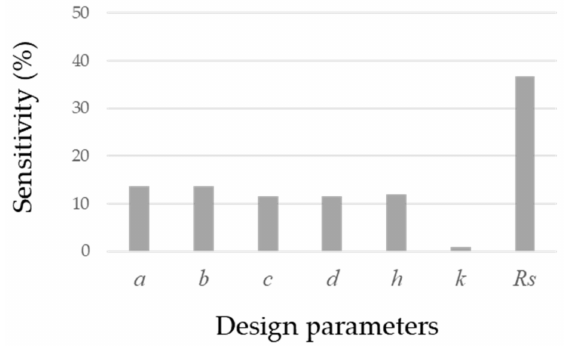
Figure 16. Design parameter sensitivity analysis of adaptive tuned MRE vibration